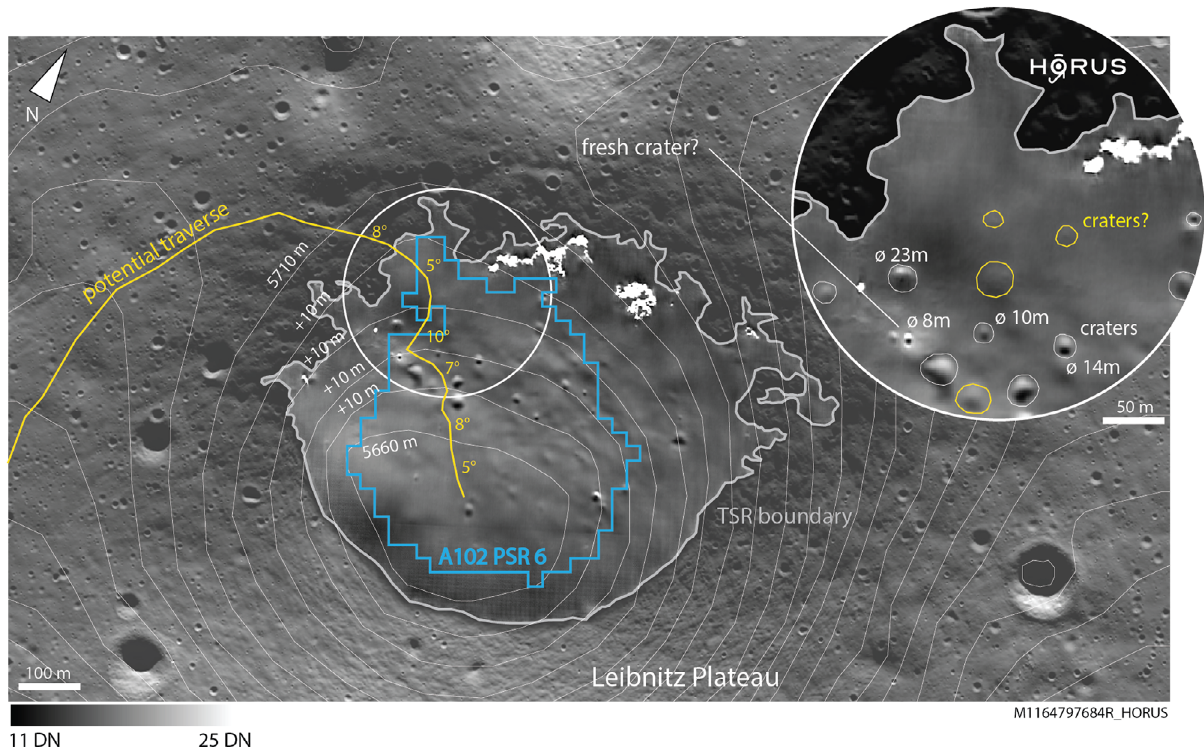
Fig. 5 Using HORUS to plan a traverse into a small permanently shadowed region. HORUS image of a potential Artemis candidate PSR (permanently shadowed region) on the Leibnitz plateau, embedded into a regular NAC (Narrow Angle Camera) image. Topography is indicated with white contour lines; each line corresponds to a 10 m elevation change. The extent of the PSR is indicated in blue, using a 20 m PSR product calculated for this particular PSR, and the boundary of the NAC-observed TSR (transiently shadowed region) is indicated in gray. The inset shows a potential access point in more detail, including a potentially fresh (bright) impact. A potential access traverse is shown in yellow, including local slope angles which never exceed ~10°. The sunlit part of the image is slightly transparent to help showcase the shadowed region; the range of digital numbers (DN) is shown at the bottom of the fi gure. Raw NAC image credits to